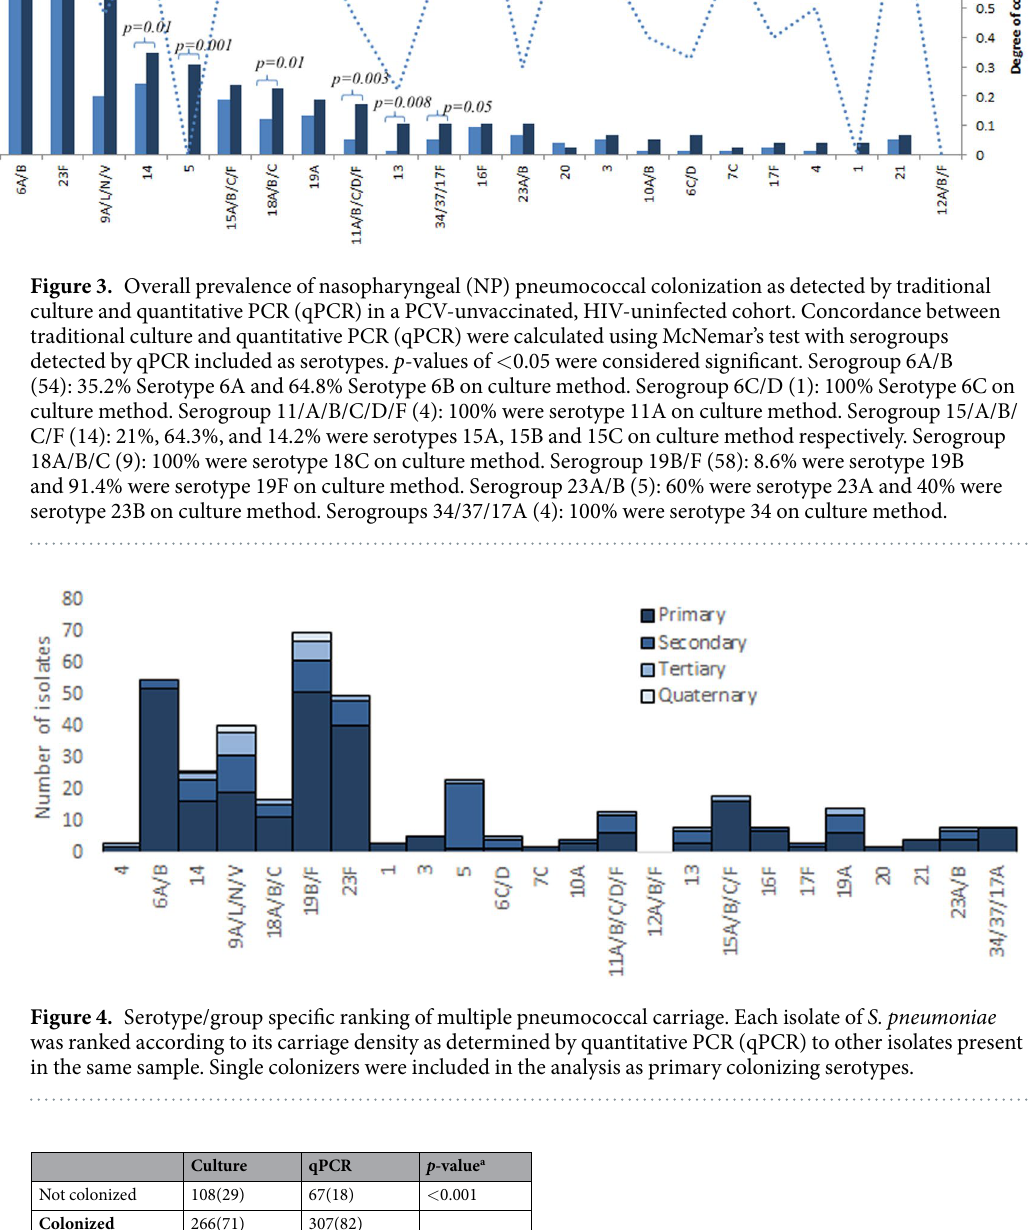
Table 2. Pneumococcal co-colonization as measured by traditional culture and quantitative molecular PCR (n = 374). Values are number (%). For multiple carriage percentage values are calculated based on total number of samples positive for LytA . PCV7, 7-valent pneumococcal conjugate vaccine. a As defined by McNemer’s test. p -values of < 0.05 were considered significant.